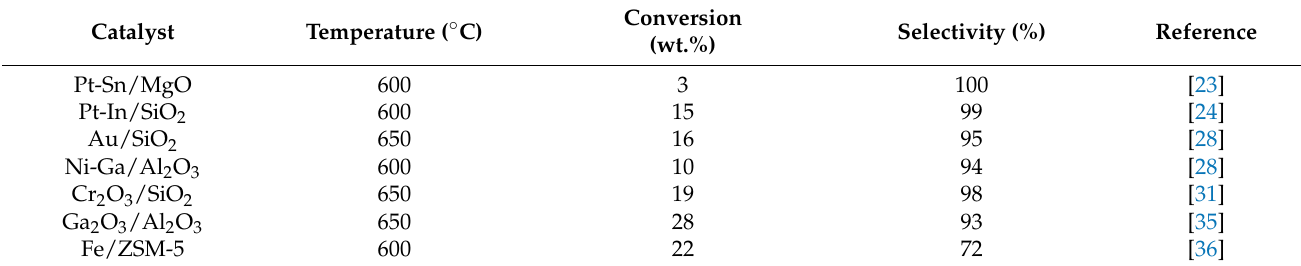
Table 2. Catalytic performance of